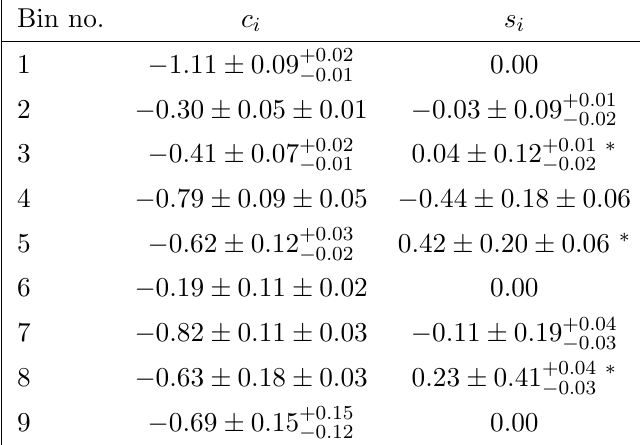
Table 2 . Values of c i and s i reported in ref. [13]. The uncertainties are statistical and systematic, respectively. The s i results marked by * in bins 3, 5 and 8 are derived from those in other bins, according to the constraints of eq. (3.2). The statistical uncertainty on these s i values include contribution from K i values according to the error propagation